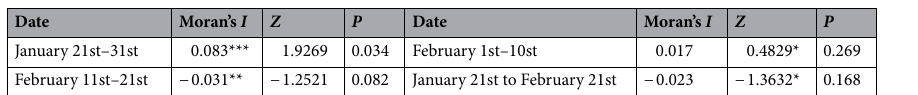
Table 3. Global Moran’s I statistics of the COVID-19 epidemic in Shandong province. *** P ≤ 0.05; ** P ≤ 0.1; * P ≤